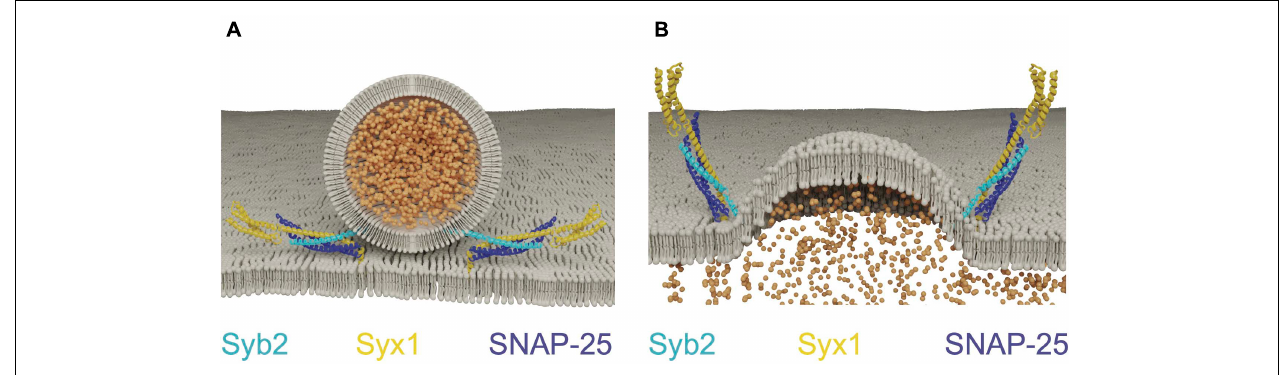
FIGURE 1 | SNAREs assemble between opposing membranes to drive membrane fusion and neurotransmitter release. (A) One helix of the v-SNARE Syb2 assembles with three t-SNARE helices (one from Syx1 and two from SNAP-25) to form a four-helical trans- SNARE complex between opposing membranes. (B) Full SNARE zippering converts the trans- SNARE complex to a cis -SNARE complex to drive membrane fusion and neurotransmitter release. PDB structures in this and subsequent figures were obtained from the cited sources and rendered on membranes to highlight their role in SV fusion. Adapted from Fernandez et al. (1998); Sutton et al.